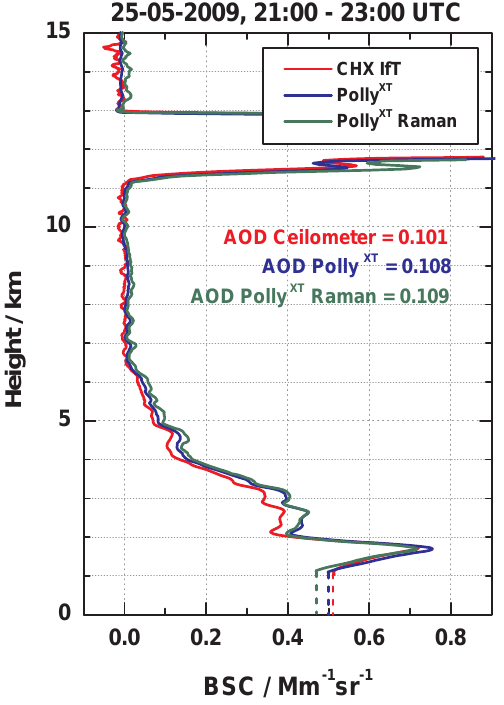
Fig. 3. Particle backscatter coefficient profiles derived from CHX ceilometer data at IfT (in red), lidar data (in blue), and Raman lidar data (in green). The AOD measured by the AERONET sun pho- tometer during the last sun hour in the evening is 0.117. The AOD from the lidar and ceilometer profiles is calculated up to